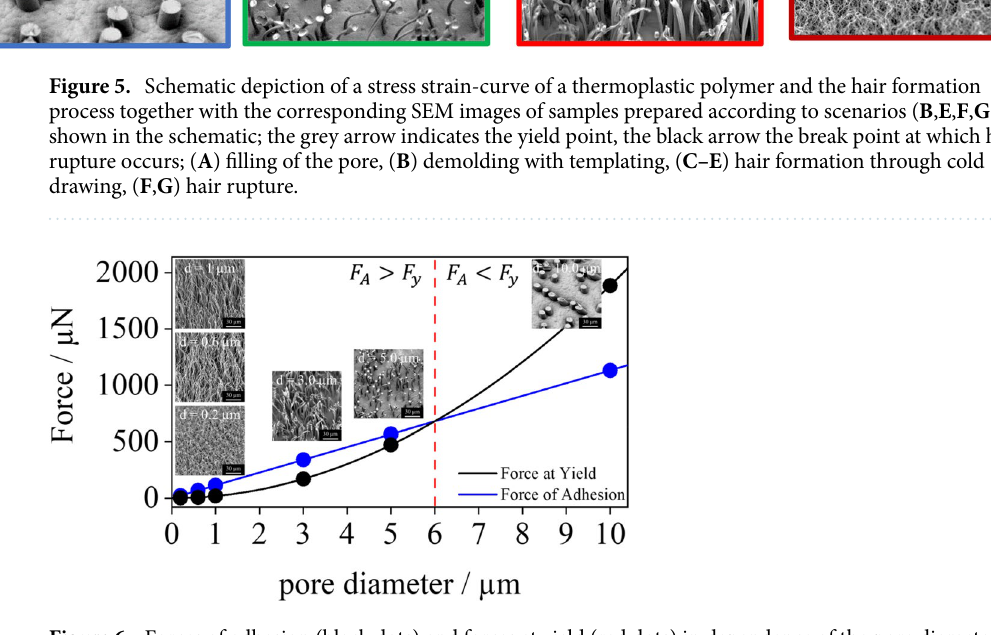
Figure 6. Forces of adhesion (black dots) and forces at yield (red dots) in dependence of the pore diameter employed. Note that the system was simplified to one pore and assumed to be under thermodynamic equilibrium, i.e., pores entirely filled. The intersection of the two force curves defines the two working regimes observed experimentally: cold drawing for the smaller pore diameter ( d ≤ 5 μm), where F A ≥ F Y , and microreplication for the larger pore diameter ( d = 10 μm), where F A < F